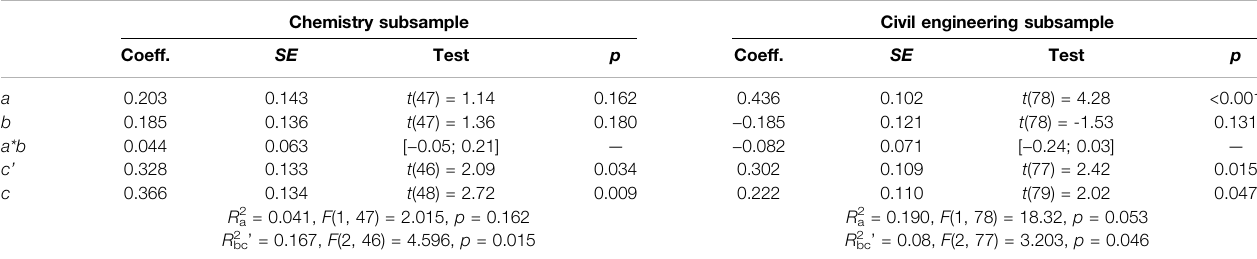
TABLE 4 | Detailed results of the mediation analysis between social embeddedness (predictor), successful academic help-seeking (mediator) and students ’ satisfaction (criterion). Chemistry subsample